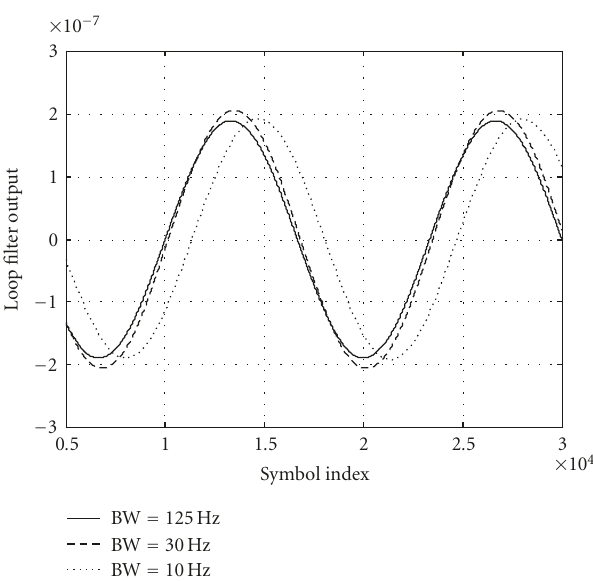
Figure 7: Loop filter output for a 3Hz sinusoidal input jitter in an LTI channel.